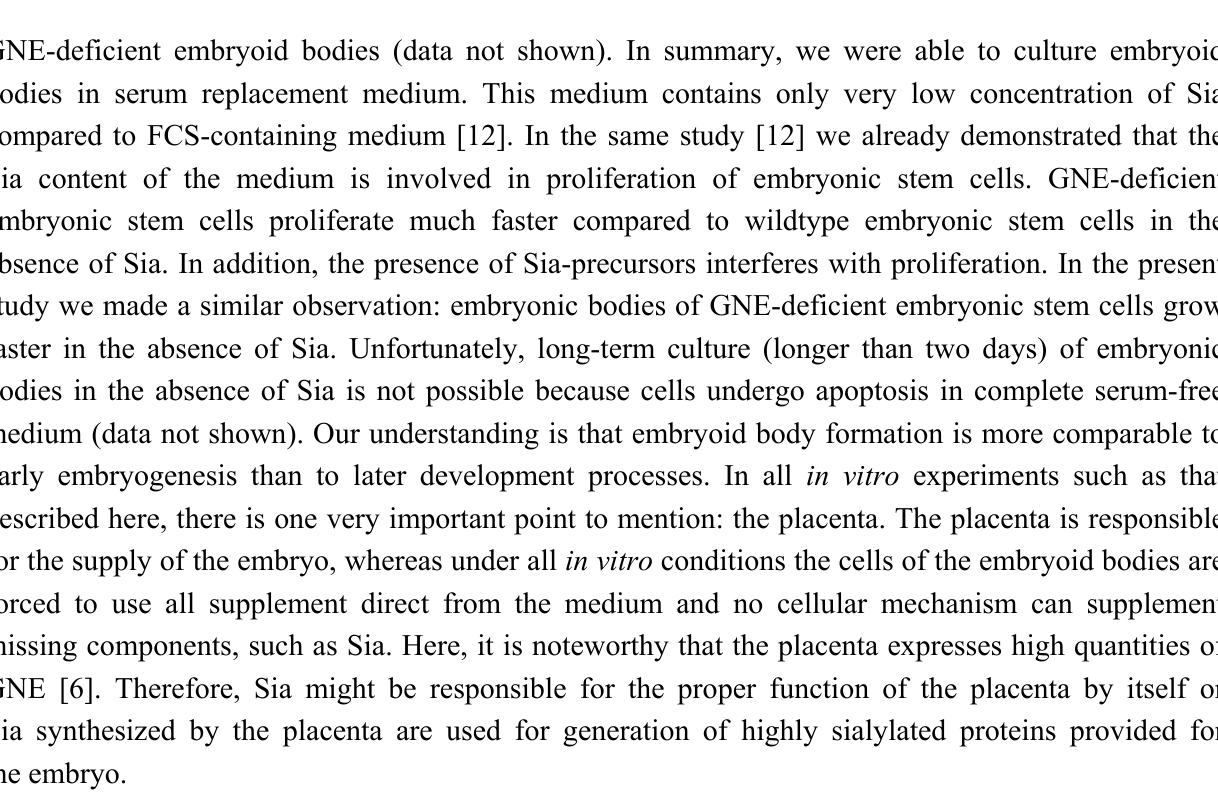
Figure 3. Embryoid body formation and qRT-PCR analysis in the absence of sialic acids. Wild-type (wt) and GNE-deficient (GNE-deficient ( − / − )) embryonic stem cells were cultured in hanging drops in sialic acid free serum replacement medium for 72 h. ( A ) Representative micrographs were shown. Bar = 100 µm; ( B ) Bars represent fold change of expression of GNE-deficient embryonic stem cells compared to wild-type embryonic stem cells. Each experiment was performed twice in